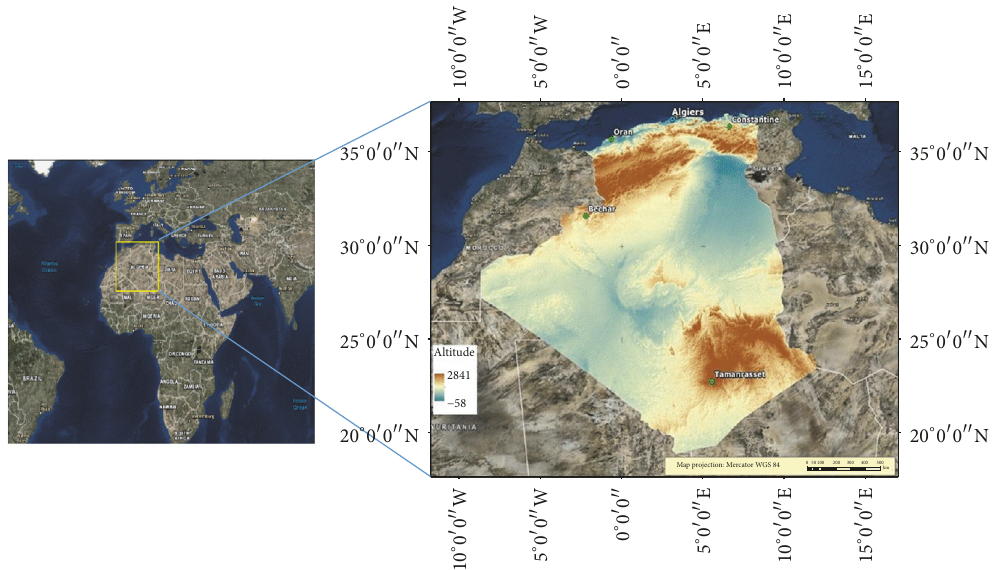
Figure 1: Location of the 5 Algerian cities selected for the study.